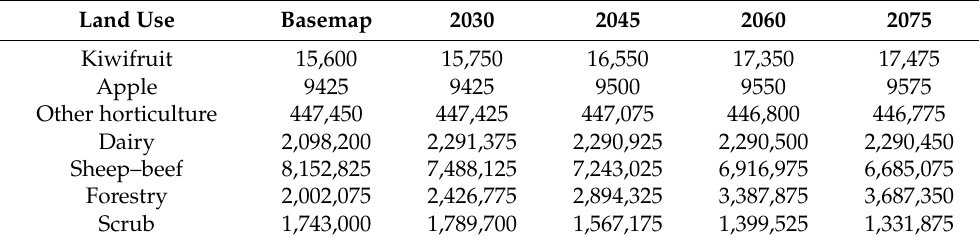
Table 2. Simulated land use (hectares) with mild climate change (Representative Concentration Pathway (RCP) 2.6.